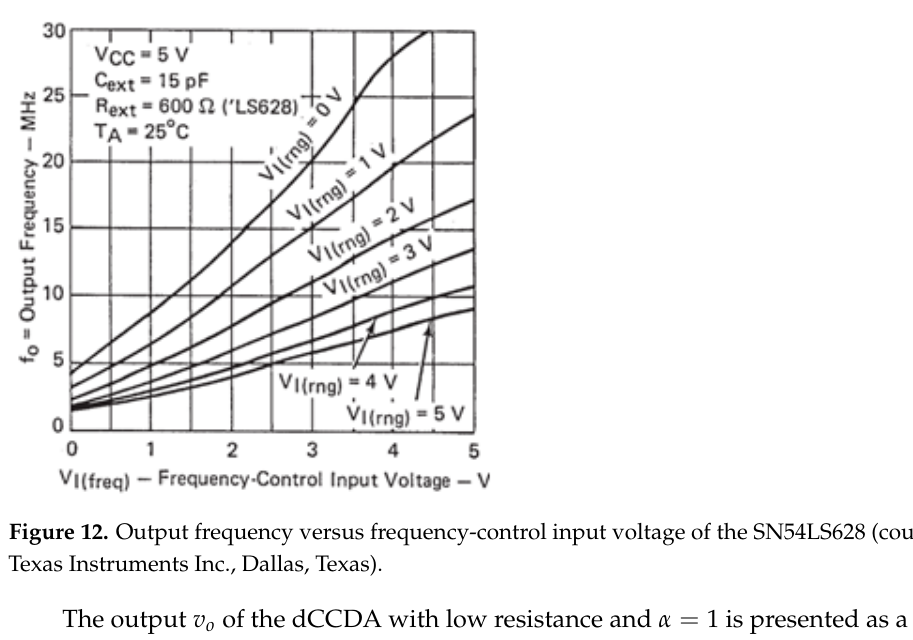
Texas Instruments Inc., Dallas, Texas).